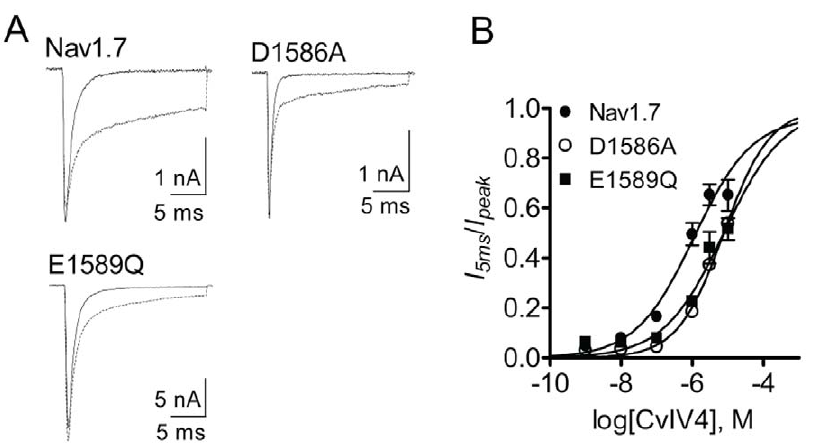
Figure 10. Effects of CvIV4 on mutant Na v 1.7 channels expressed in HEK293 cells. A. Substitution of negatively charged amino acids in the Domain IV S3–S4 loop with neutral residues (D1586A, E1589Q) reduces the effects of 1 m M CvIV4 on Na v 1.7. B. Dose-response curves for CvIV4 on wildtype and mutant Na v 1.7 channels.